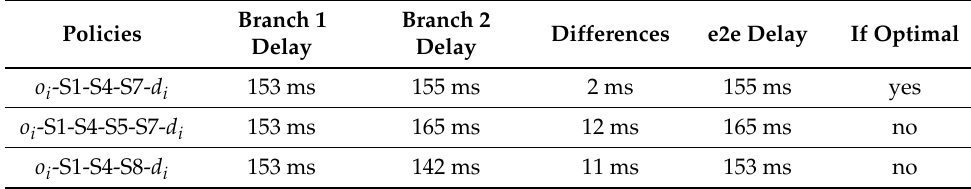
Table 3. Performance of different scheduling policies, where o i represents the flow ingress and d i represents the flow egress node.